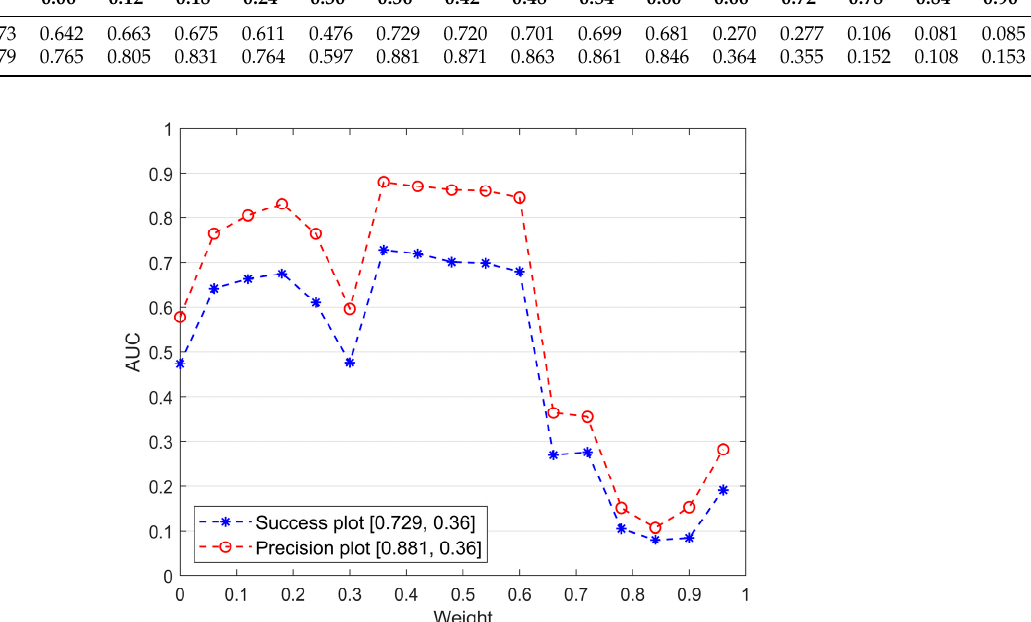
Figure 7. Effects of the weights of optical flow remapping on tracking performance. The legend presents the maximum values of the AUC and their indexes.